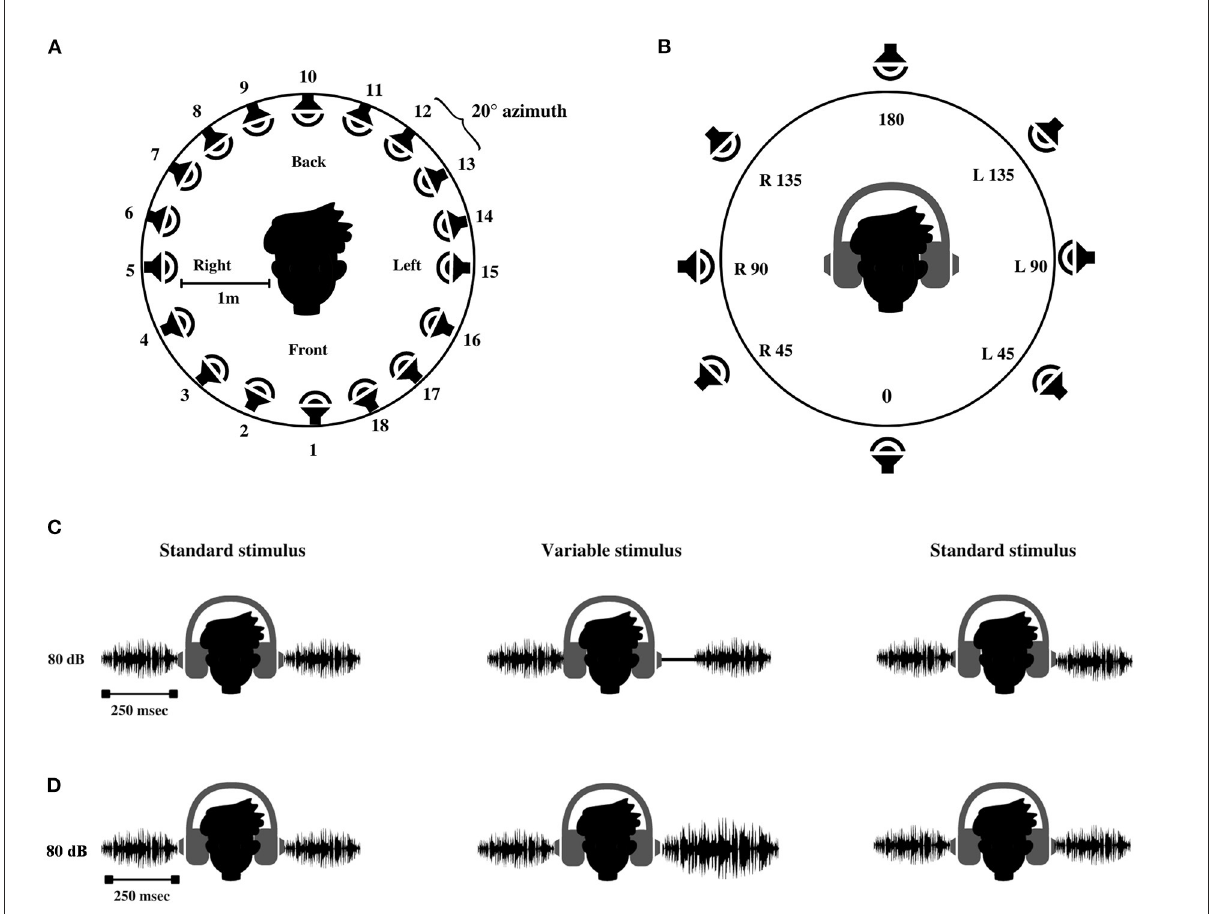
FIGURE2 Schematic representation of (A) loudspeakers setup used for testing spatial acuity in free field. (B) Interface used for stimulus and response acquisition in virtual auditory space identification (VASI) test. The alphanumerical code represents the location of spatial percept created within the head. 0 ◦ -At the midline front, 180 ◦ -At the midline back, R45–45 ◦ azimuth toward the right ear; R90–90 ◦ azimuth toward the right ear, R135–135 ◦ azimuth toward the right ear; L45–45 ◦ azimuth toward the left ear, L90–90 ◦ azimuth toward the left ear, and L135–135 ◦ azimuth toward the left ear. (C) Interaural time difference test and (D) interaural level difference